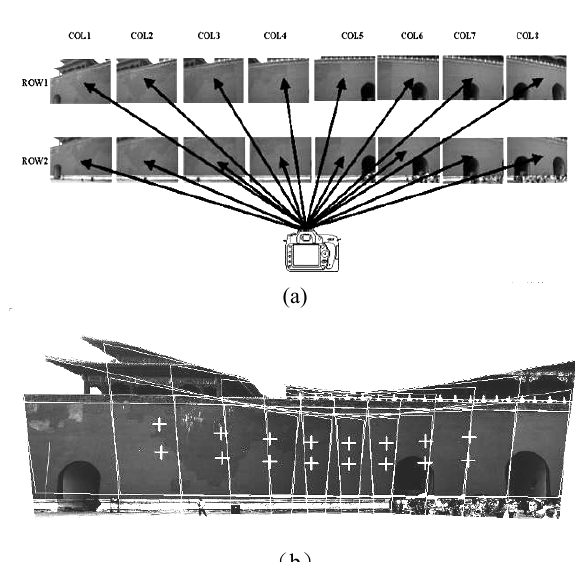
Figure1. Figure (a) shows the image matrix of 2 rows and 8 columns gained by scanning photography on one station. Figure (b) shows the mosaic Ortho-image from images in figure (a). And the white crossings present the positions of images’ centre, the white lines shows the boundaries of each